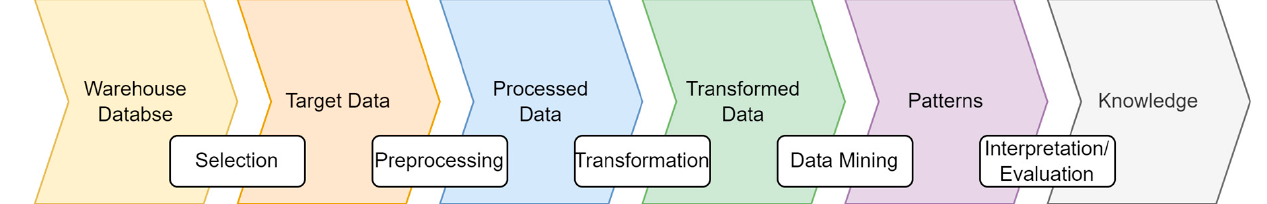
Figure 1. The knowledge discovery and data mining